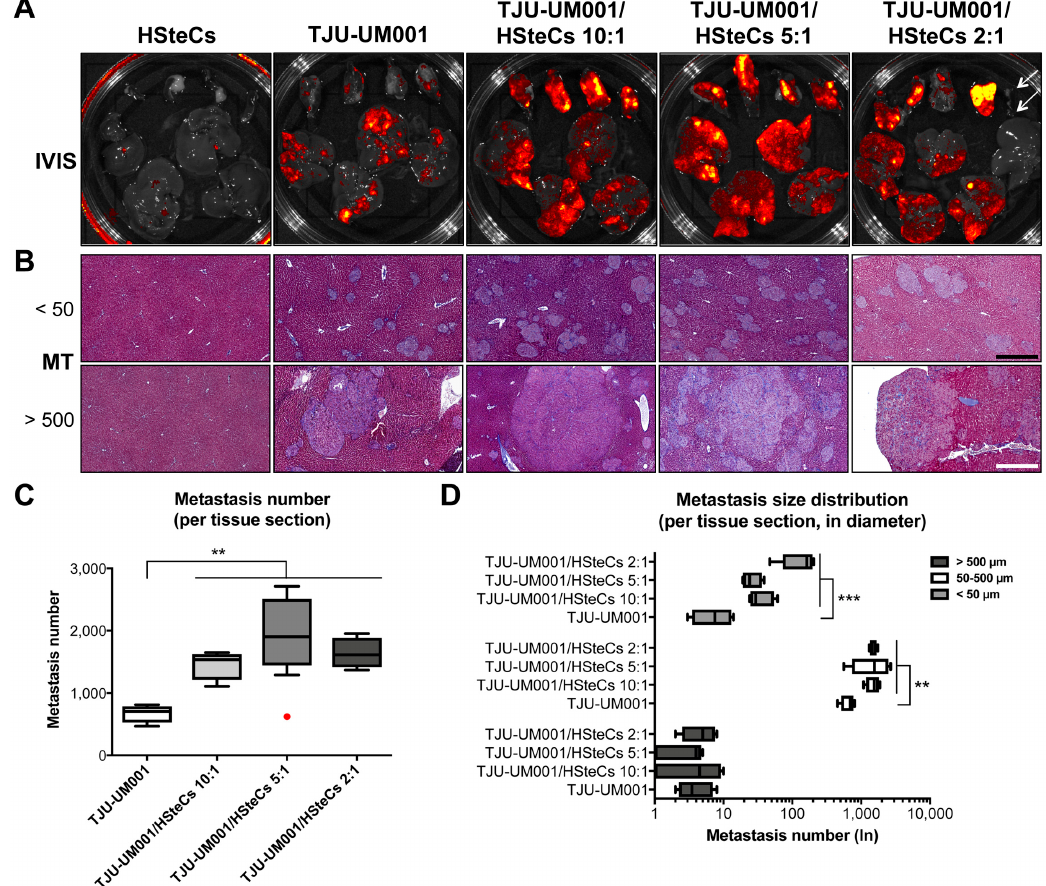
Figure 3. HSteCs interact with TJU-UM001 cells to favor UM liver metastasis and extracellular matrix production. ( A ) Ex vivo fluorescence imaging (IVIS) of the spleen (top part of the Petri dish) and liver (bottom part of the Petri dish) of triple-immunodeficient mice ( N = 4 per condition) bearing UM metastases generated with the TJU-UM001 cell line inoculated alone or in combination with human HSteCs (ratios 10:1, 5:1 or 2:1). The red to yellow signal corresponds to malignant lesions at 6 weeks post-inoculation. Arrows on the last panel indicate the spleen and liver of a mouse that was not inoculated with human cells. ( B ) Masson’s Trichrome (MT) stain reveals the production of collagen (in blue) in the vicinity of UM micro-metastases ( < 50 µ m) and macro-metastases ( > 500 µ m). Black scale bar, 50 µ m; white scale bar, 500 µ m. ( C ) The metastasis number for the four groups is represented as box-and-whisker plots, with the median indicated by the horizontal line. The red dot corresponds to an outlier. One-way ANOVA with Dunnett’s post hoc test, * p < 0.05 and ** p < 0.01. ( D ) The metastasis size distribution in diameter ( < 50 µ m, 50–500 µ m or > 500 µ m) for the four groups is represented as box-and-whisker plots, with the median indicated by the horizontal line. One-way ANOVA with Dunnett’s post hoc test, * p < 0.05, ** p < 0.01 and *** p < 0.001.